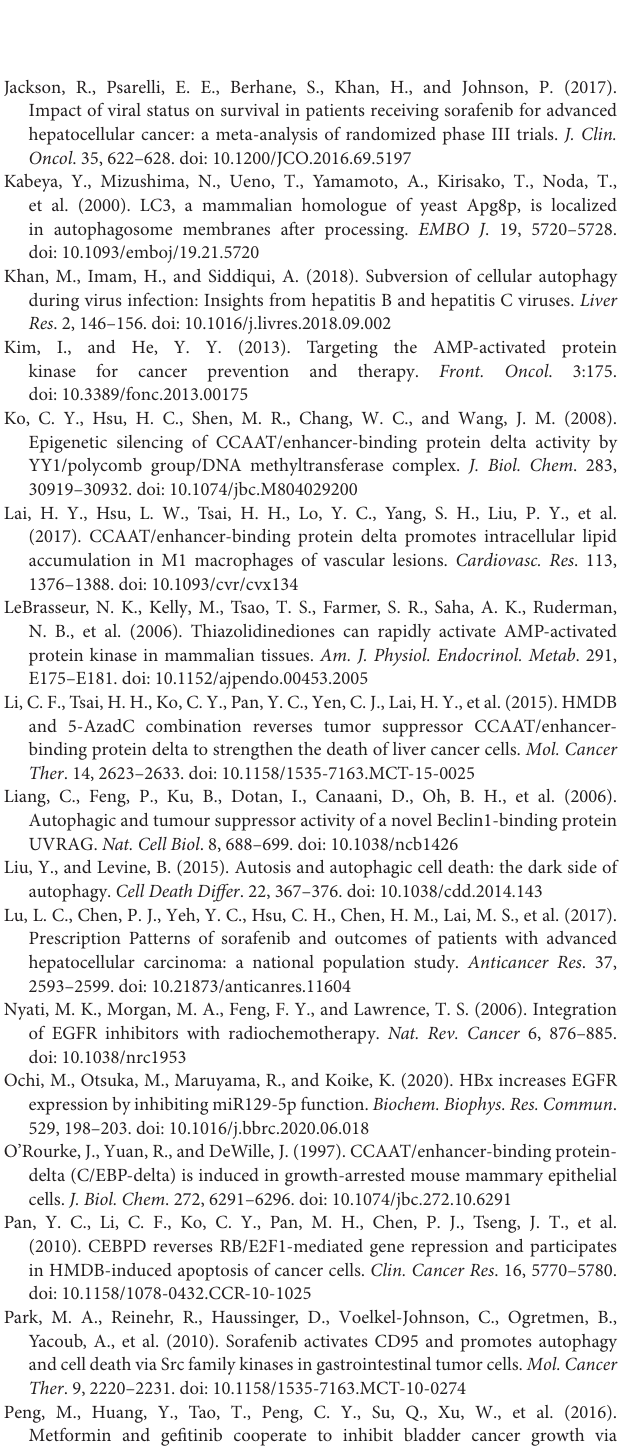
Supplementary Figure 3 | Methylation states on the CEBPD promoter are not different in Huh7 and Hep3B cells. The CpG methylation status of CEBPD promoters in Huh7 and Hep3B cells was determined using MSP assays. Supplementary Figure 4 | The effects of sorafenib and the AMPK inhibitor compound C on Src phosphorylation in liver cancer cells. (A) Two types of liver cancer cells (Huh7 and Hep3B) were treated with or without sorafenib (2.5 µ M) for